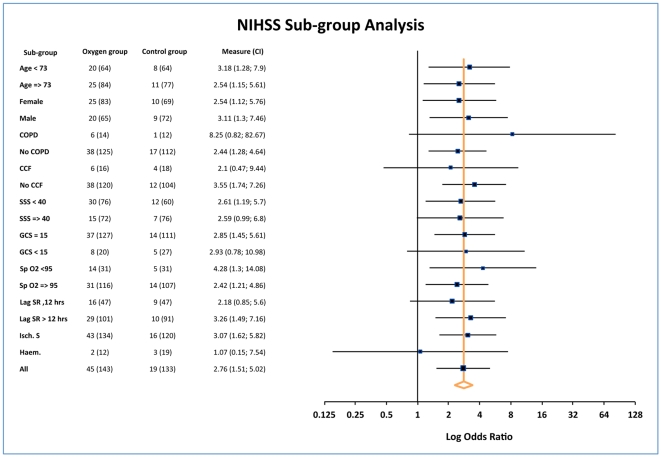
Forest plot of the odds of a 4 point or greater improvement of the
National Institute for Health Stroke Scale (NIHSS) score between
randomization and week 1.The figures in the oxygen and control columns are the number of events
(NIHSS improvement) followed by the total number in brackets which
comprises events and non-events. The figure shows that the odds of
improving with oxygen treatment were similar in all the subgroups
tested. The apparent adverse effect in the haematoma group is not
significant, and likely to be due to very small numbers of patients with
improvement at one week in this subgroup (one improved in the oxygen
group versus 2 on the control group. COPD: chronic obstructive pulmonary
disease, CCF: congestive cardiac failure, SSS: Scandinavian Stroke
Scale, GCS: Glasgow Coma Scale, SpO2: oxygen saturation, Lag SR: time
lag between stroke onset to recruitment.